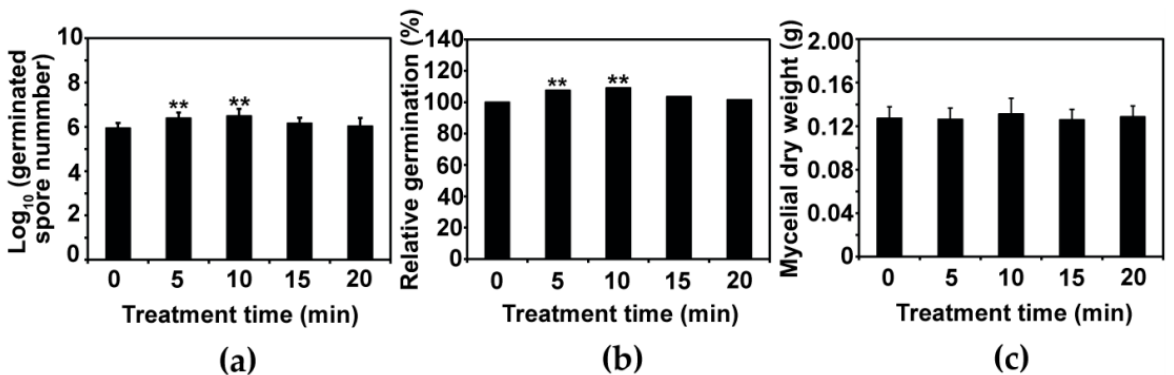
Figure 2. Spore germination and growth of A. oryzae post treatment with a plasma jet for 5, 10, 15, and 20 min, or without treatment (0 min = control). ( a ) Log-scale number of germinated spores in a 1 mL suspension with or without treatment with a plasma jet. ( b ) The relative germination percentage (%) of plasma-treated samples compared with that of the control (0 min, 100%). ( c ) The dry weight of the fungal mycelia grown for 48 h in a 50 mL culture. Each value is indicated as the mean and standard deviation of 6–9 replicate measurements. ** p <